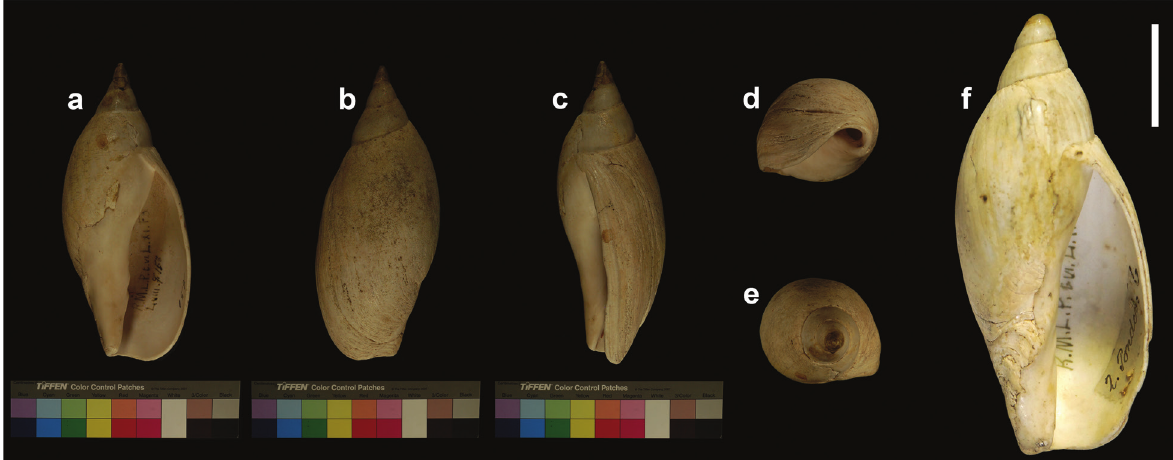
Figure 8. Voluta ancilla abbreviata , figured by Lahille (1895). a–e Correspond to pl. XI, fig. 3 and pl. VIII, fig.158 f Corresponds to pl. II, fig. 66 a, f Apertural view b Dorsal view c Lateral view d Umbilical view e Apical view. Scale bar: 5 cm.